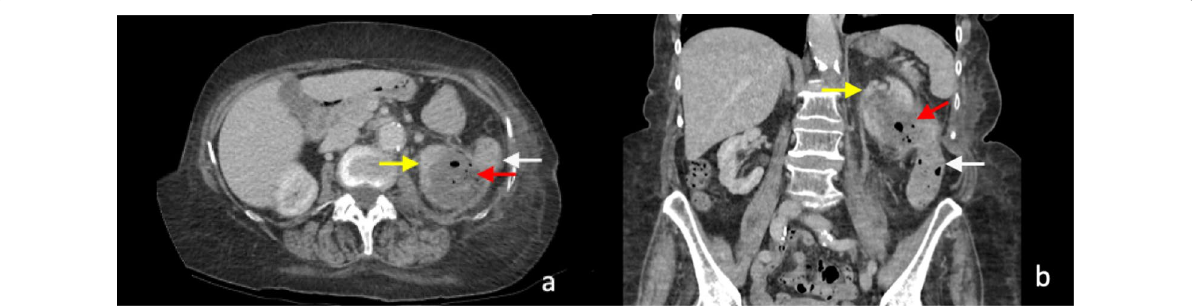
Fig. 14 a Axial and b coronal enhanced CT images of a nephrocolonic fistula approximately 9 months following completion of 42 Gy of stereotactic ablative body radiotherapy of a left clear cell renal cell carcinoma. Faecal material is present within the fistulous connection (red arrow) between the descending colon (white arrow) and left kidney (yellow arrow)